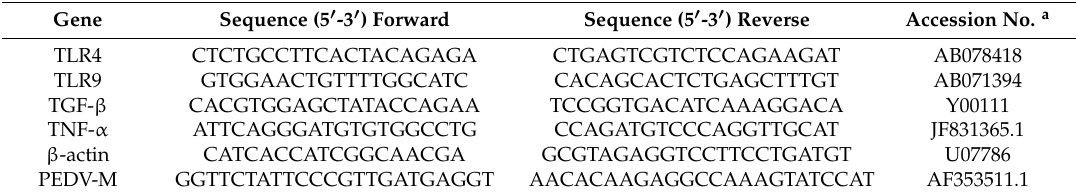
Table 1. Primer sequences used in this study.